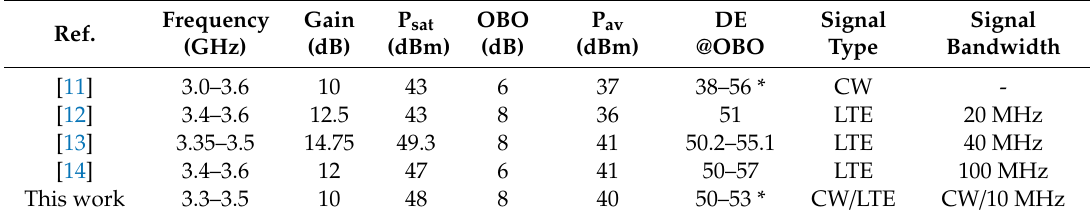
Figure 14. The measured spectrum of the designed Doherty power amplifier at an average output power of 40 dBm. Table 1. Achievements of previous works.